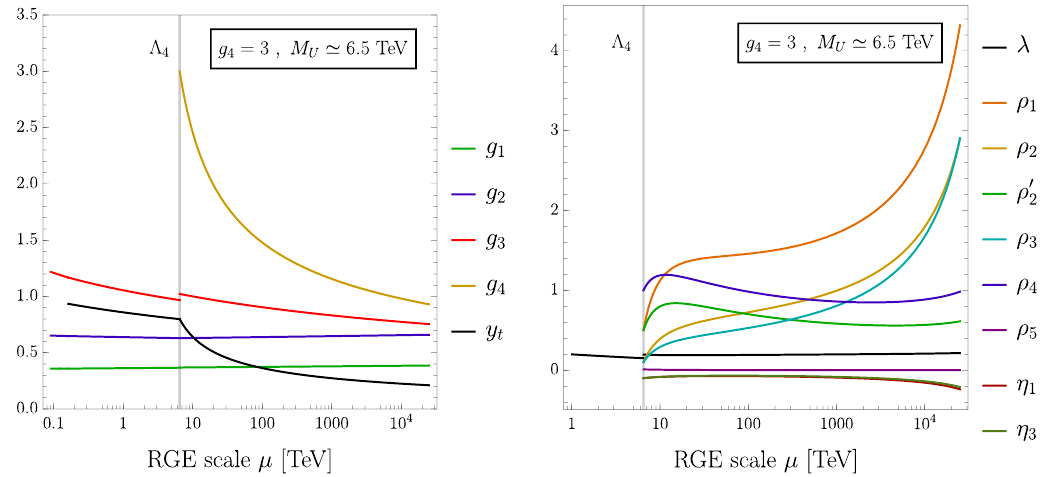
Figure 1 . RG running of the gauge and top Yukawa couplings (left) and quartic couplings of the scalar potential (right) for the benchmark presented in table 2.